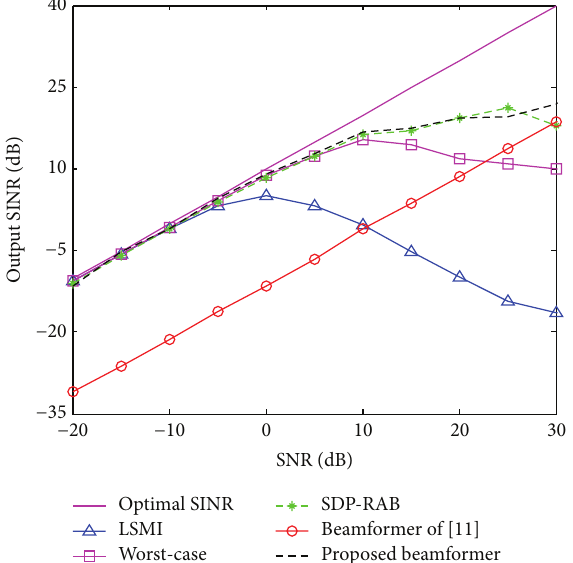
Figure 19: Values of 𝛽 versus the SNR.